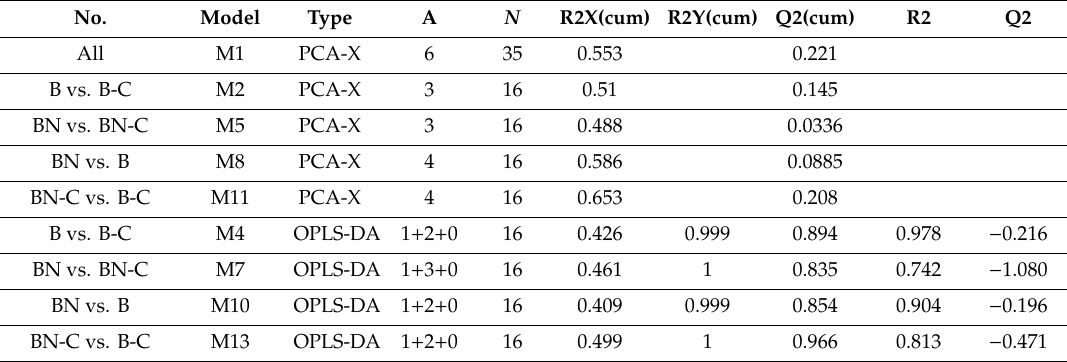
Table 1. Inter-sample PCA and OPLS-DA analysis-related